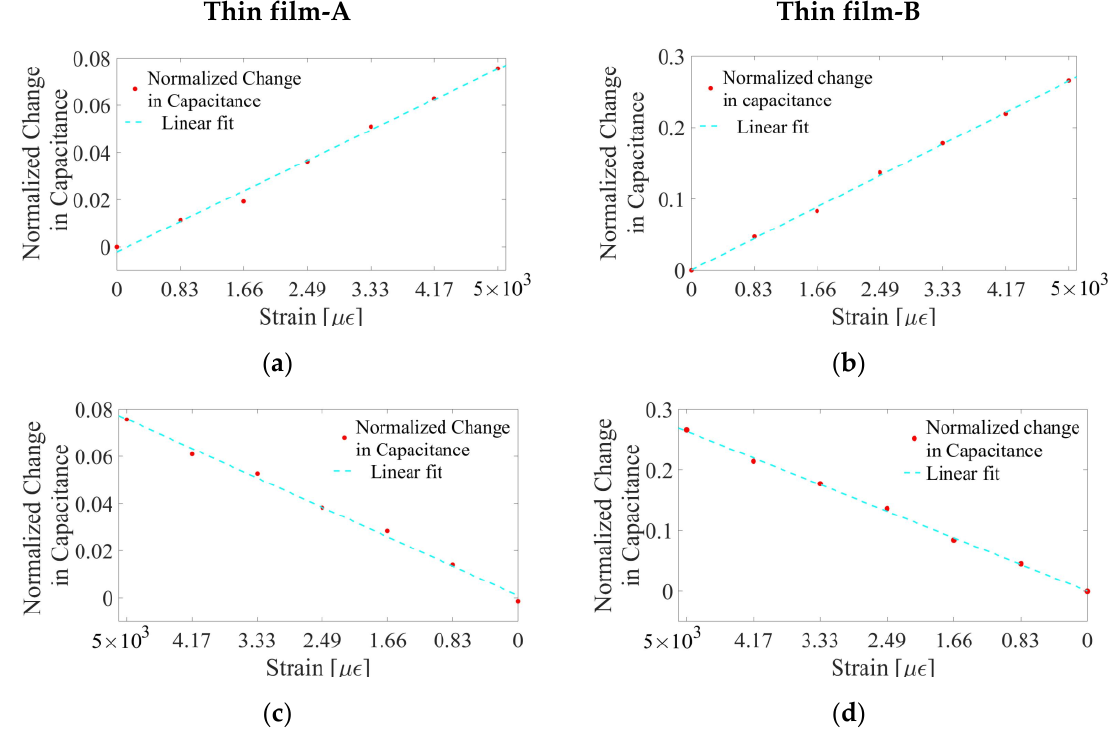
Figure 11. ( a ) Thin films-A and ( b ) -B were stretched, and the change in capacitance with respect to